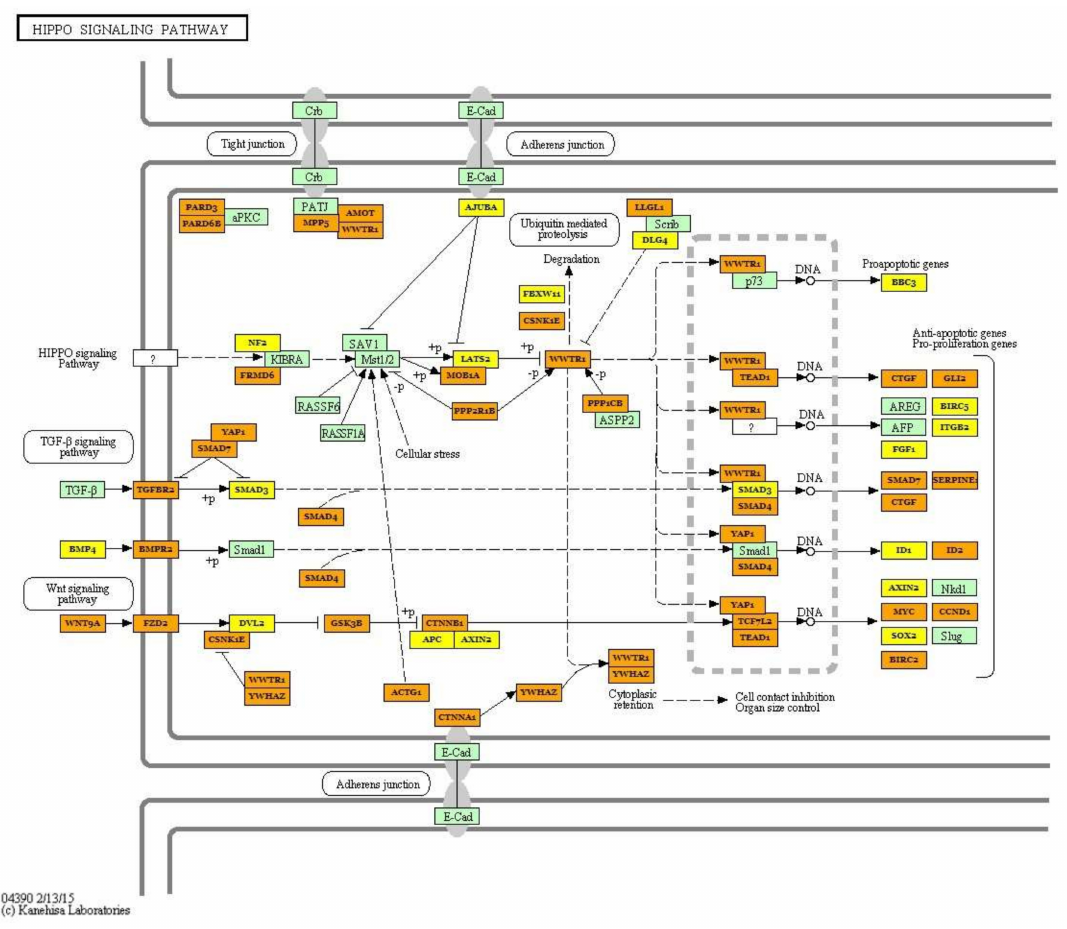
Figure 6. The Hippo signalling pathway identified as the most regulated by detected differentially expressed miRNAs depends on muscle mass. Green frame represents genes engaged in the pathway. Targeted genes regulated by identified miRNAs were marked orange (genes included in more than one pathway) and yellow (genes included only in one pathway) (KEGG database; hsa04390). Black arrows stand for a molecular interaction or relation, while dotted arrows stand for an indirect link or unknown